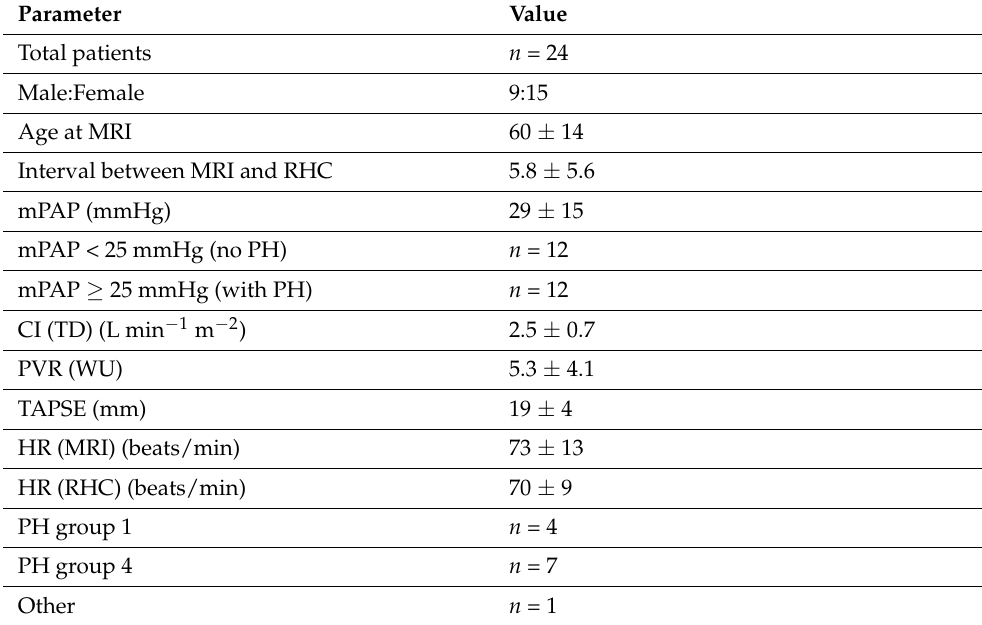
Table 1. Patient characteristics.